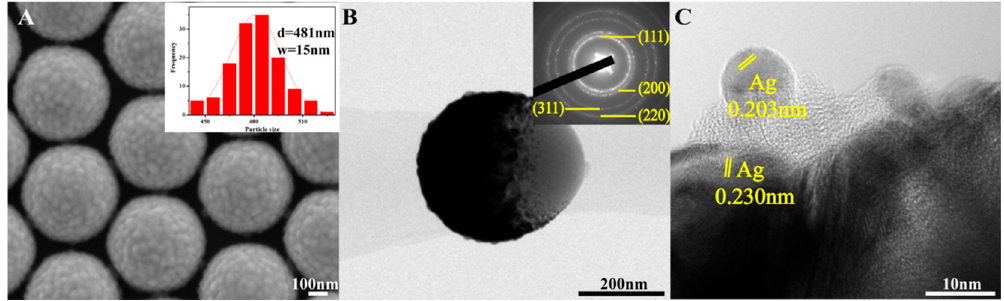
Figure 1. ( A ) SEM, ( B ) TEM, and ( C ) HRTEM images of a SiO 2 /Ag/SiO 2 nanocap arrays. The insets are the size distribution and the Ag SAED pattern.